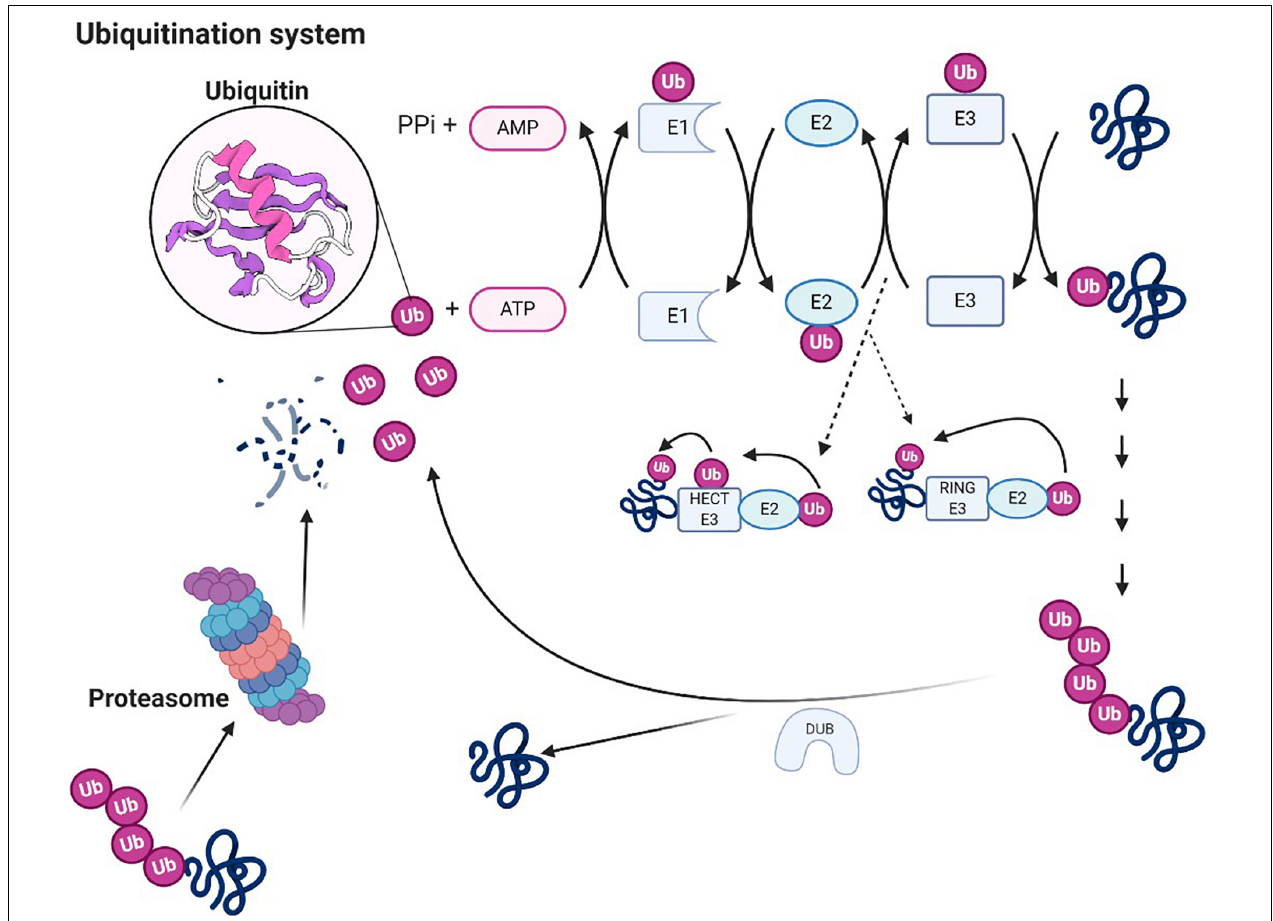
FIGURE 3 | Ubiquitin system. Ubiquitin molecules can be covalently linked to other substrates to form ubiquitin chains. A chain of four or more ubiquitin units constitutes proteasome 26S. Ubiquitin is an ATP-dependent process catalyzed by three enzymes (E1, E2, and E3), which also confer specificity to the process. The first reaction catalyzed by E1 is responsible for the activation of ubiquitin. E1 transfers ubiquitin on cysteine to E2. Through the activity of transferase, E2 transfers the ubiquitin to E3 ligase (two groups of protein ubiquitin ligase, HECT E3 enzymes and ring E3s, the way they transfer ubiquitin is exactly different), which binds ubiquitin to the Lys residue of the target protein. Polyubiquitinated protein can be degraded by 26S proteasome, and ubiquitin can be recovered under the action of the deubiquitinating